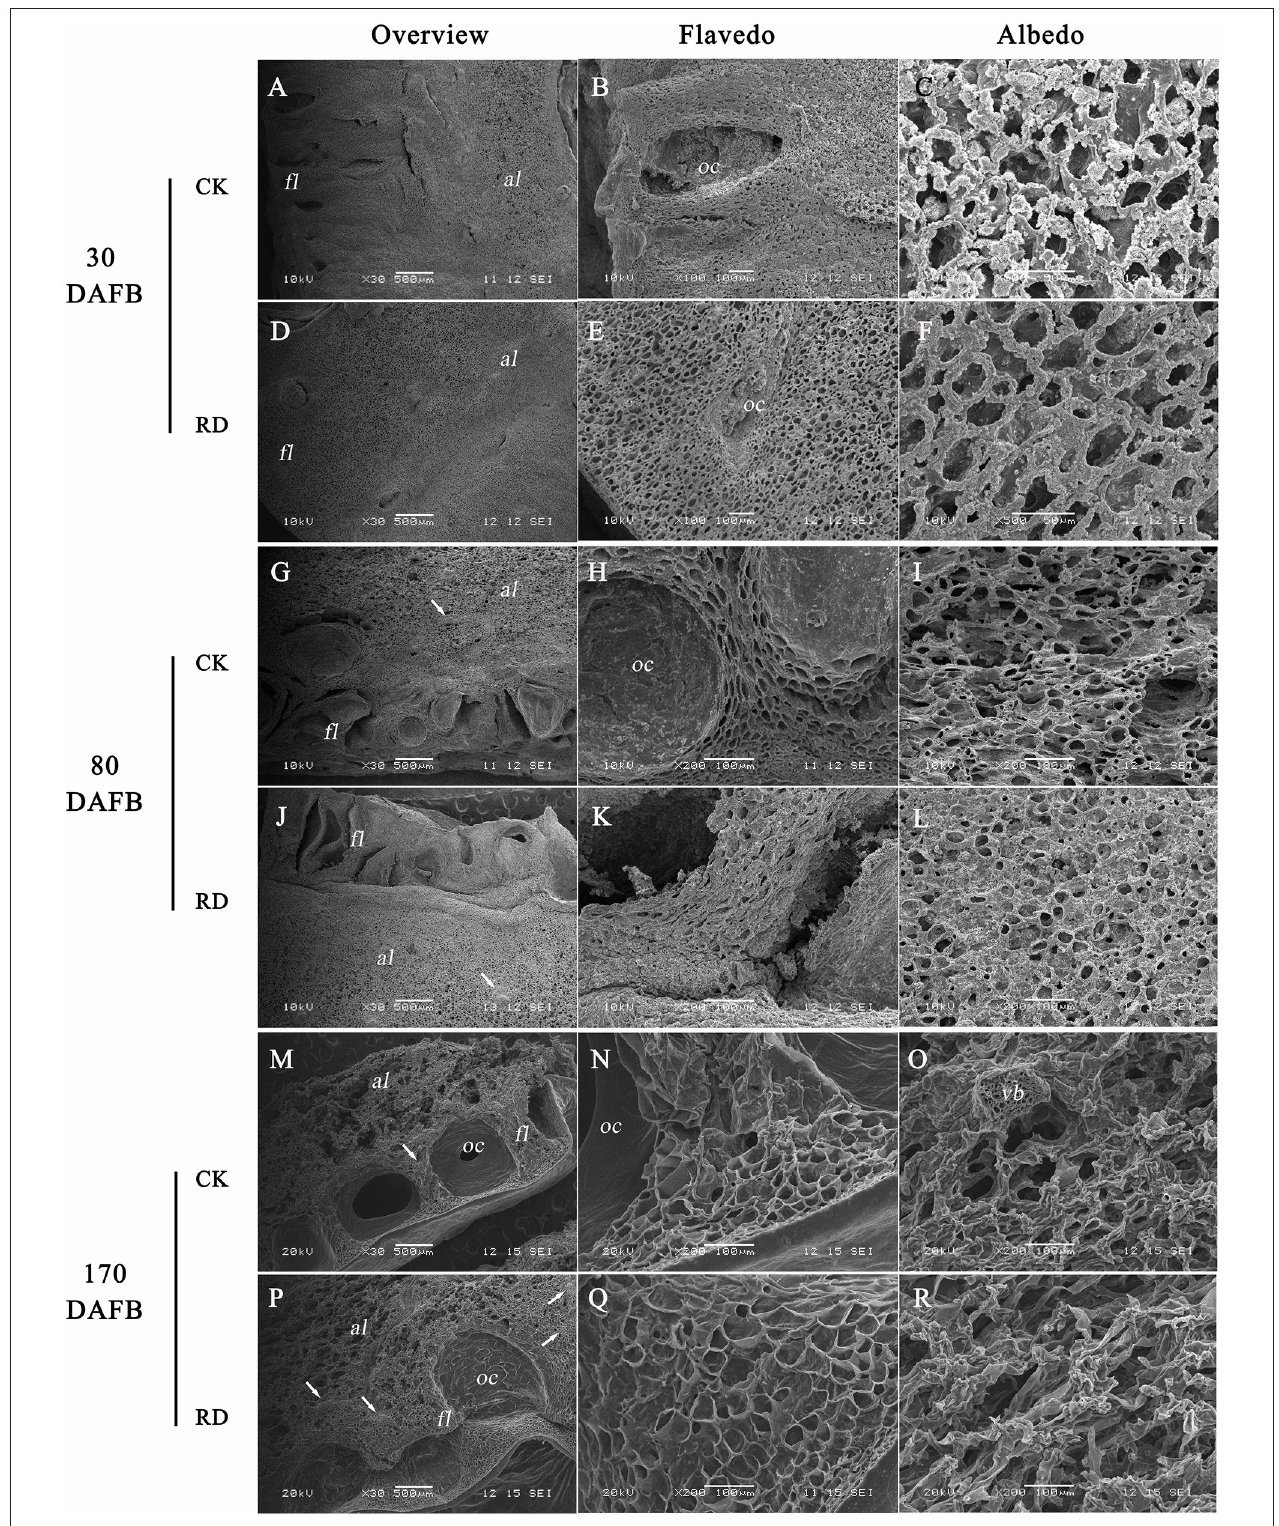
FIGURE 2 | Development of peel RD at three fruit development stages. The overview (A,D) , flavedo (B,E) and albedo (C,F) of CK and RD peels at 30 DAFB. The overview (G,J) , flavedo (H,K) and albedo (I,L) of CK and RD peels at 80 DAFB. The overview (M,P) , flavedo (N,Q) and albedo (O,R) of CK and RD peels at 170 DAFB. The white arrow shows the vascular bundle in the peel. fl, flavedo; al, albedo; oc, oil cell; vb, vascular bundle.